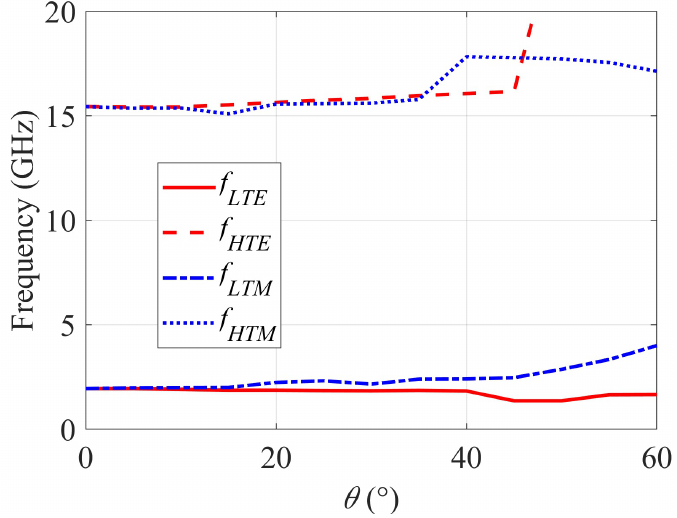
Figure 13. Stop-band limits versus incidence